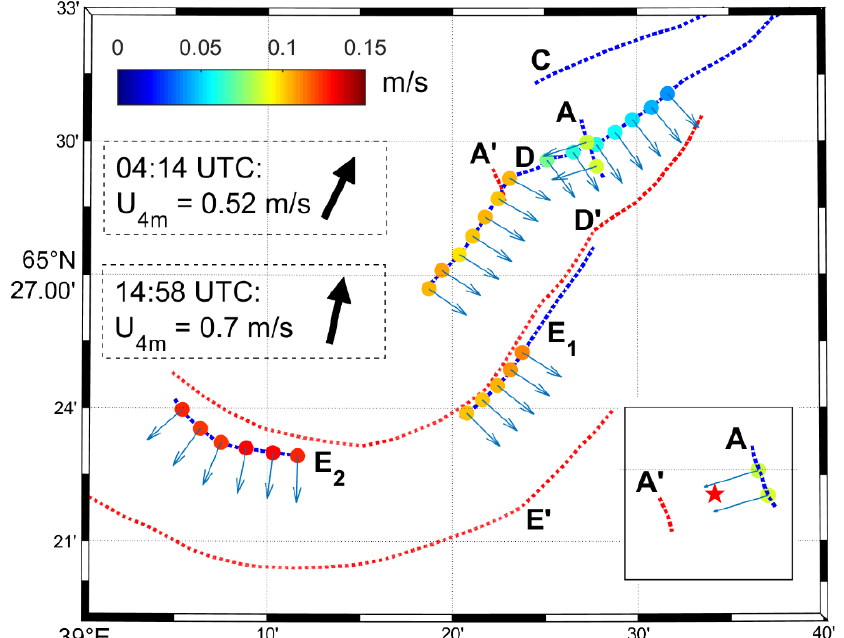
Figure 14. Propagation speed of ISWs derived from sequential Radarsat-1/-2 images on 1 August 2012. Blue (red) dotted lines show locations of ISW leading waves identified in Radarsat-1 (Radarsat-2) image at 04:14 (14:48) UTC. Colored circles with arrows denote ISW propagation speed and direction, respectively. Letters mark particular ISW trains. Two dashed boxes show information on tidal speed and direction at 4 m depth at times of SAR acquisitions. Black box in the bottom right corner shows propagation speed and direction for the waves A and A’, and the location of polygon 7 (shown by red star).